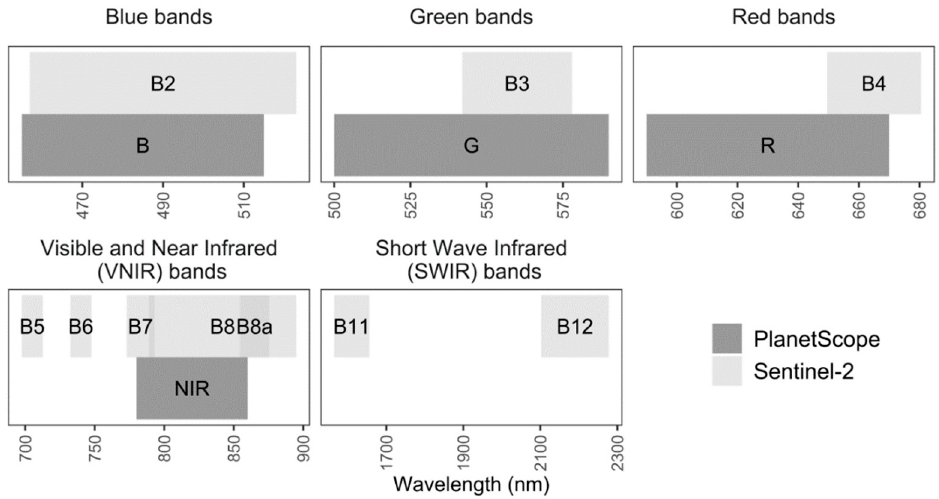
Figure 1. Spectral resolution and wavelength range of PlanetScope (PS) and Sentinel ‐ 2 (S2) bands.